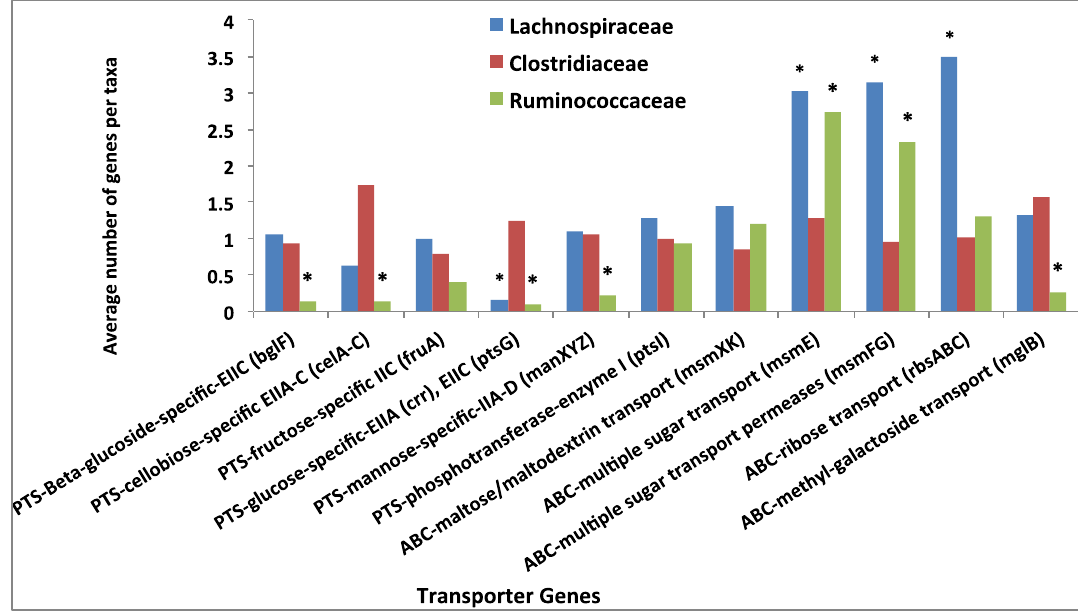
Figure 8. A comparison of average abundance of sugar transport genes in each genome of Lachnospiraceae, Clostridiaceae, and Ruminococcaceae. (*) Genes showing significant differences between groups (Clostridiaceae as reference) in best fit between negative binomial or Poisson regression models as determined by the likelihood ratio test ( p -value < 0.05).